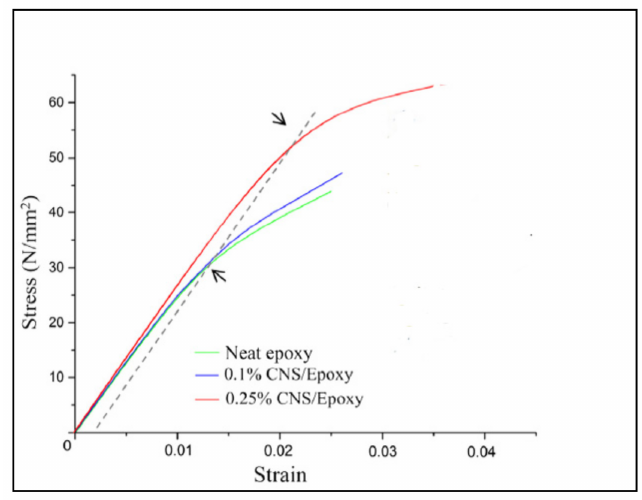
Figure 39. Stress–strain curve of composite materials and neat epoxy [2].